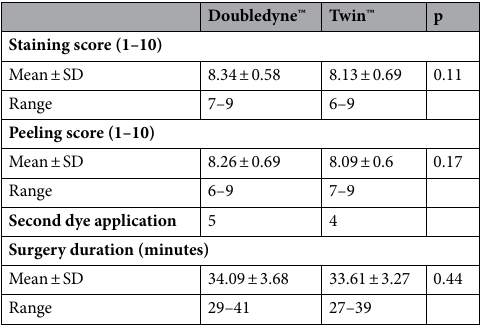
Table 2. Scores regarding quality of staining and peeling using DoubledyneTM and TwinTM, numbers of second dye application and surgery duration with statistical difference values